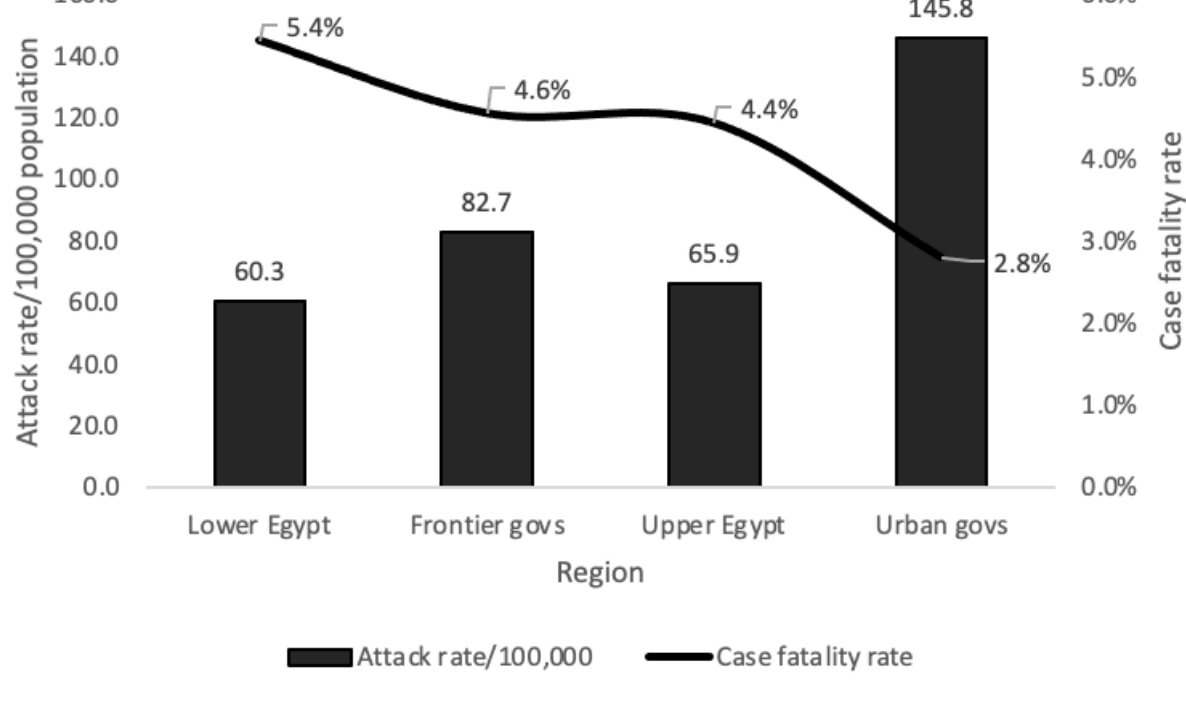
Figure 4. Distribution of COVID-19 attack rates and case fatality rates by region, National Egyptian Disease Surveillance, February to July 2020. Govs: